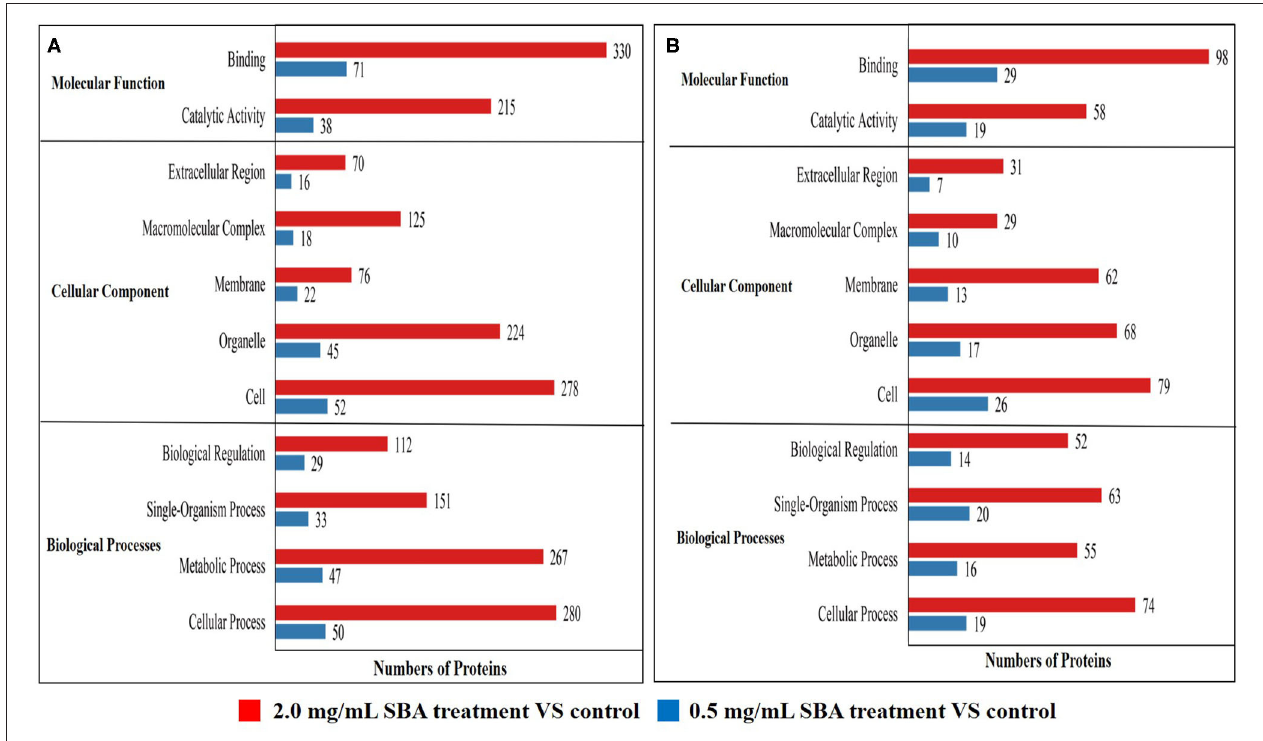
FIGURE 6 | Statistical distribution chart of differentially expressed proteins under each GO enrichment. Enrichment analysis was performed based on biological process, cellular component and molecular function. (A) The enriched down-regulated proteins analysis based on biological process, cellular component, and molecular function; (B) The enriched up-regulated proteins analysis based on biological process, cellular component, and molecular